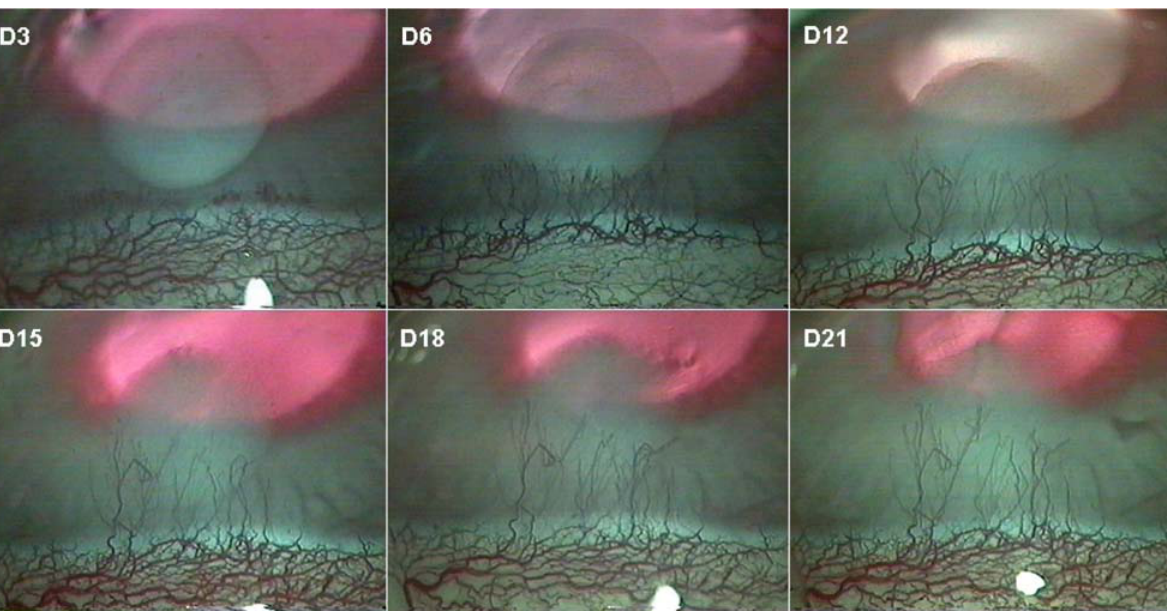
FIGURA 3 – Fotografias mostrando a progressão do processo angiogênico nos dias 3, 6, 12, 15, 18 e 21, após a cauterização.